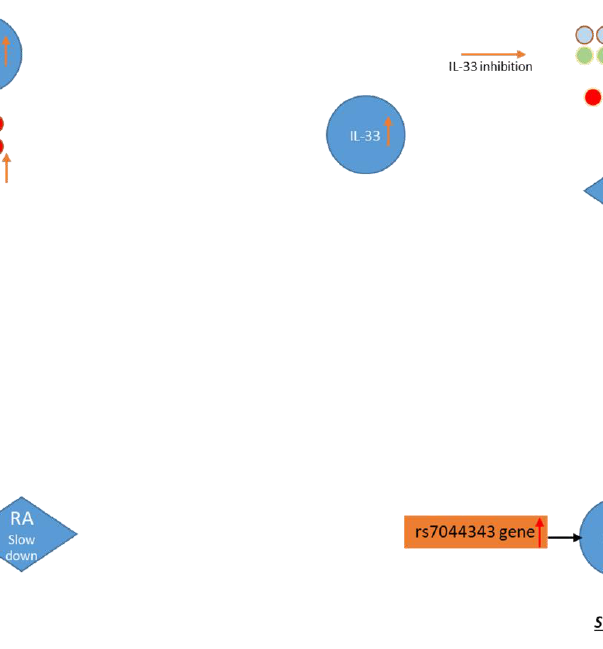
Figure 1. Interleukin (IL)-31 and IL-33 involvement in autoimmune disorders: Behçet’s disease (BD), systemic lupus erythematosus (SLE), rheumatoid arthritis (RA), systemic sclerosis (SSc). TSLP: thymic stromal lymphopoïetin, Tregs: regulatory T cells, MDSCs: myeloid-derived suppressor cells.